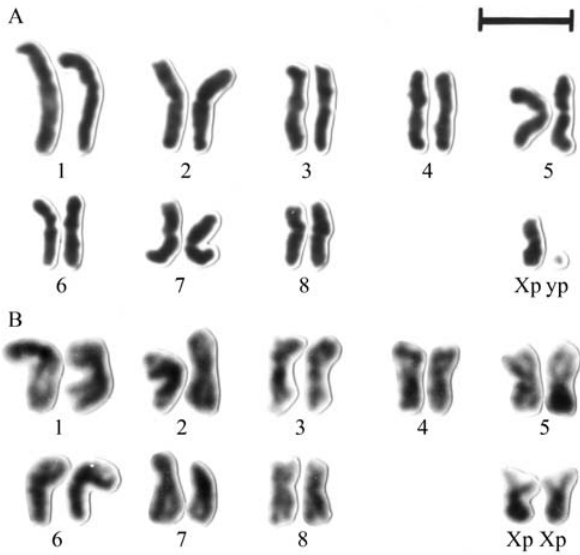
Figure 1 - Karyotypes of Astylus variegatus : A) Male, with 2n = 16+Xy p , note the extremely small y p sex chromosome; B) Female, with 2n = 16+XX p . Scale bar = 5 μ m.